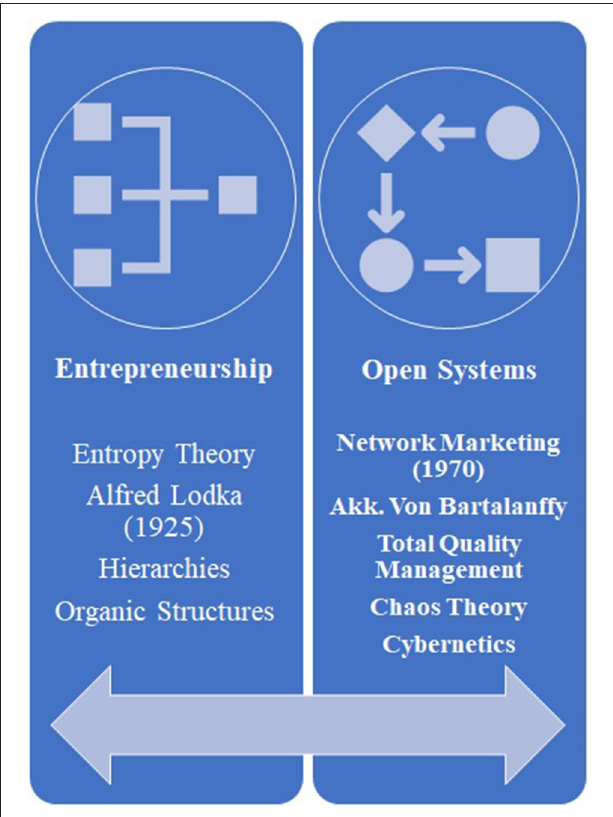
FIGURE 2 | Historical development of network marketing as the basis for the online